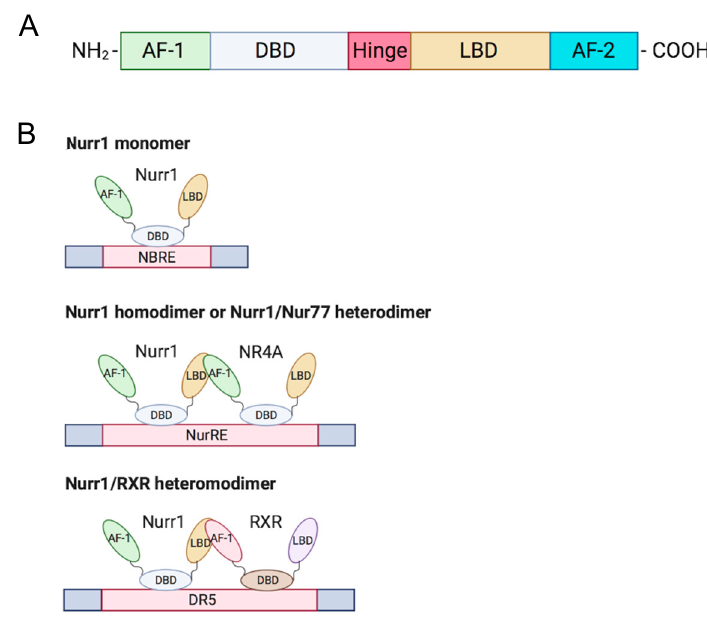
Figure 1. Structure and DNA-binding elements of Nurr1. ( A ) Nurr1 structure ( B ) DNA-binding elements of monomeric, homodimeric, and heterodimeric Nurr1. AF: activation function; DBD: DNA-binding domain; LBD: ligand-binding domain; NRBE: nerve growth factor-induced clone